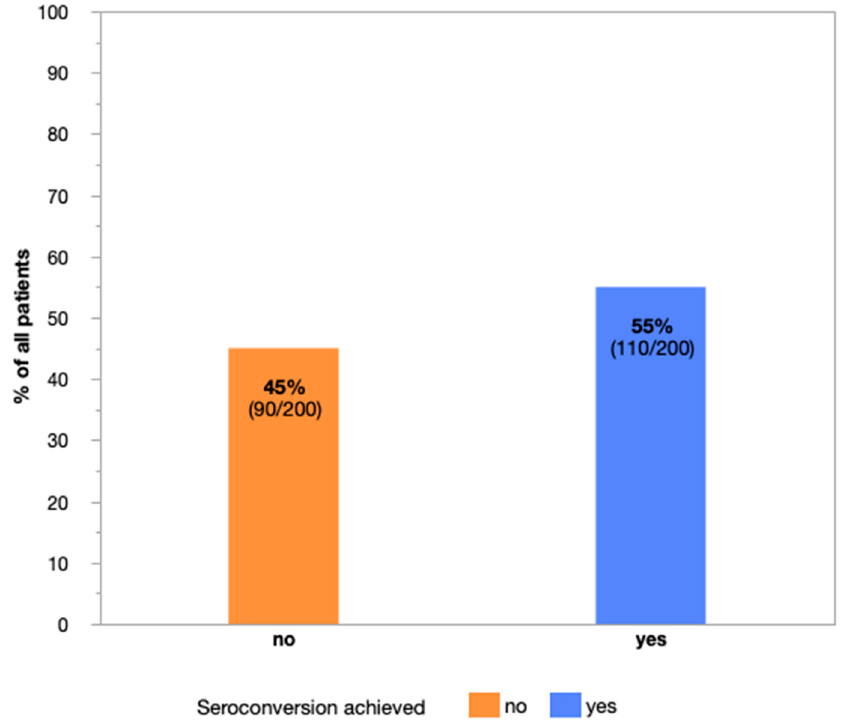
Figure 2. Proportion of patients with and without seroconversion (anti-spike IgG antibodies to